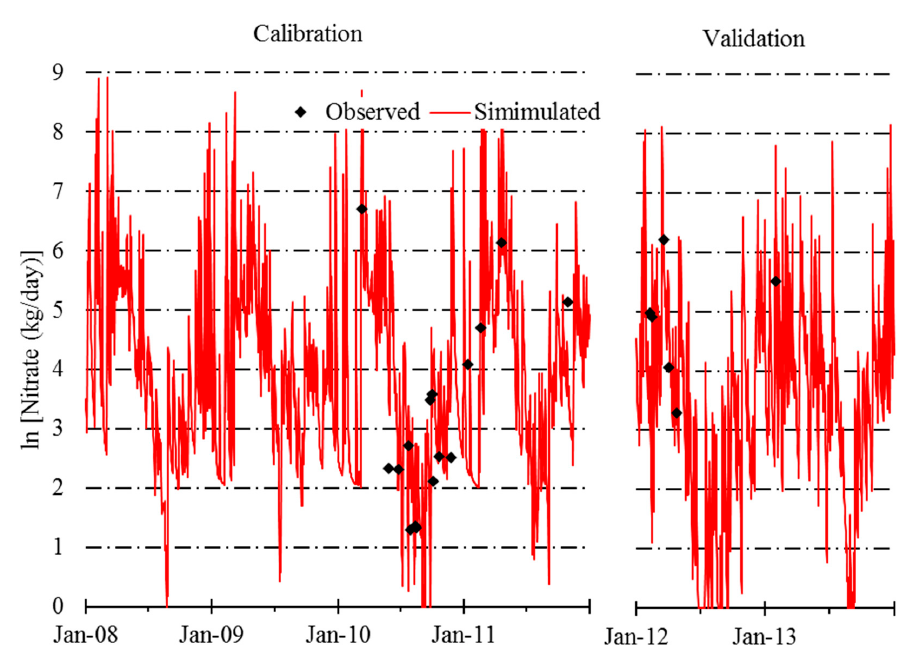
Figure 5. Calibration and validation of nitrate (NO 3 ‒ N) loading to the stream.